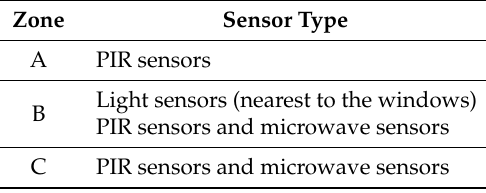
Figure 6. The layout of the office space. Table 2. Sensor layout.